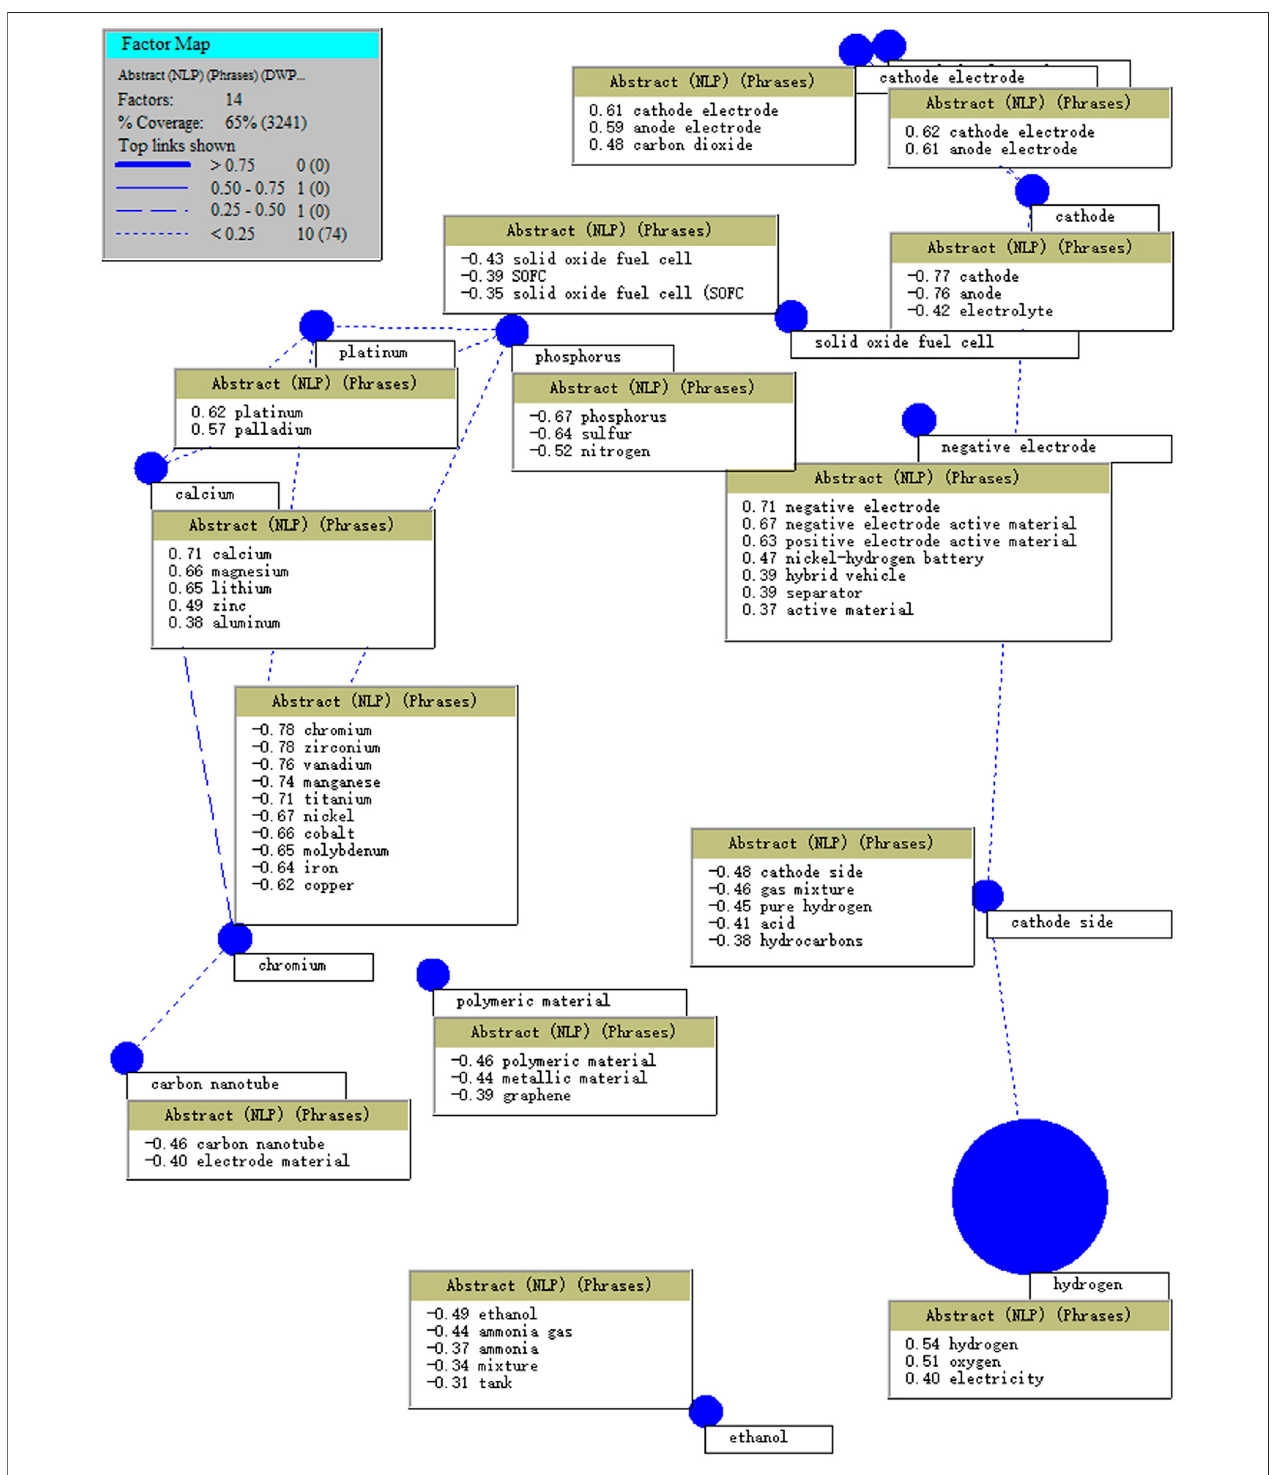
FIGURE 7 | Identifying the core technological components using